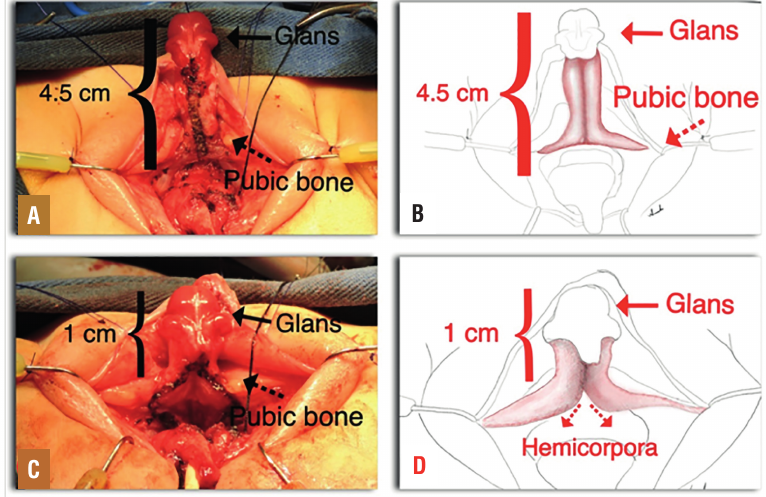
Figure 3 - Patient 2, 12 months old. A) and B) Detachment of the two hemicorpora in the midline (Arrow), up to the middle third of the phallic shaft. C) and D) Completed, corporeal sparing clitoroplasty showing a 3.5cm reduction in clitoral length. The proximal two thirds of each hemicorpora were laterally mobilized and anchored to the pubic bone (Red Dotted